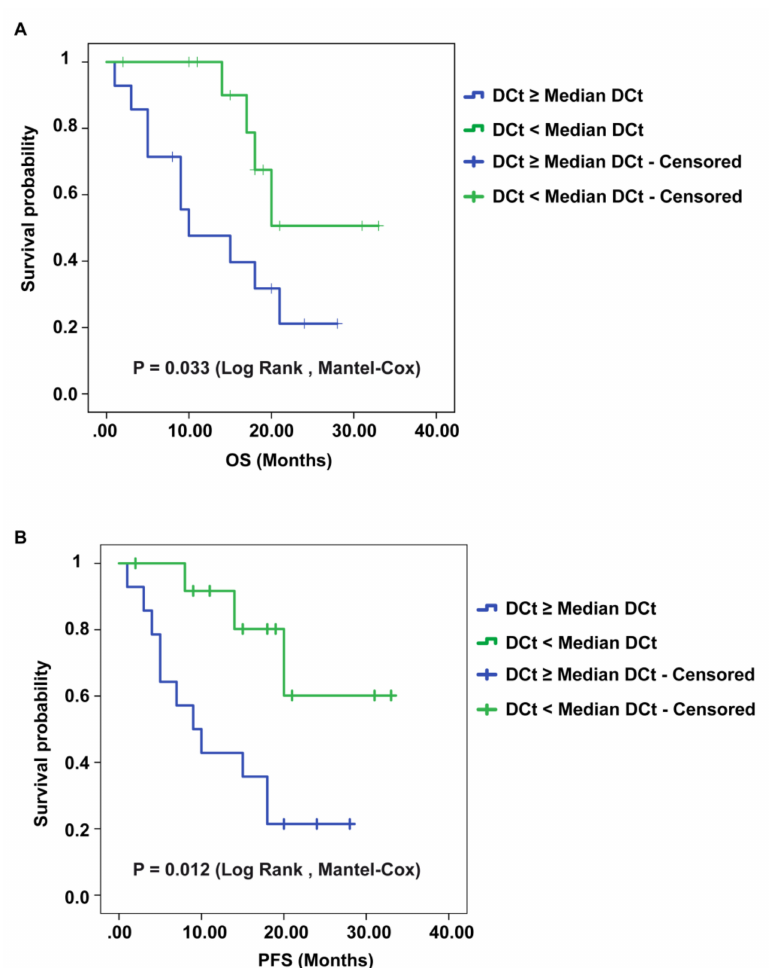
Figure 5. Kaplan–Meier overall survival (OS) and progression-free survival (PFS) curves of GBM patients, based on the expression of circSMARCA5. Patients having a lower expression of circSMARCA5 (DCt ≥ Median DCt) survive less ( A ) show a shorter PFS ( B ) than patients with a higher expression of circSMARCA5 (DCt < Median